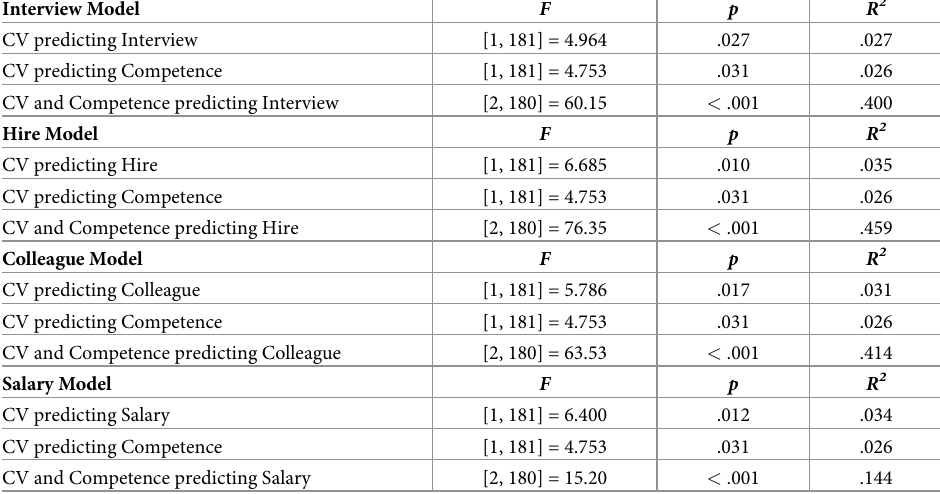
Table 2. Model summaries for mediation